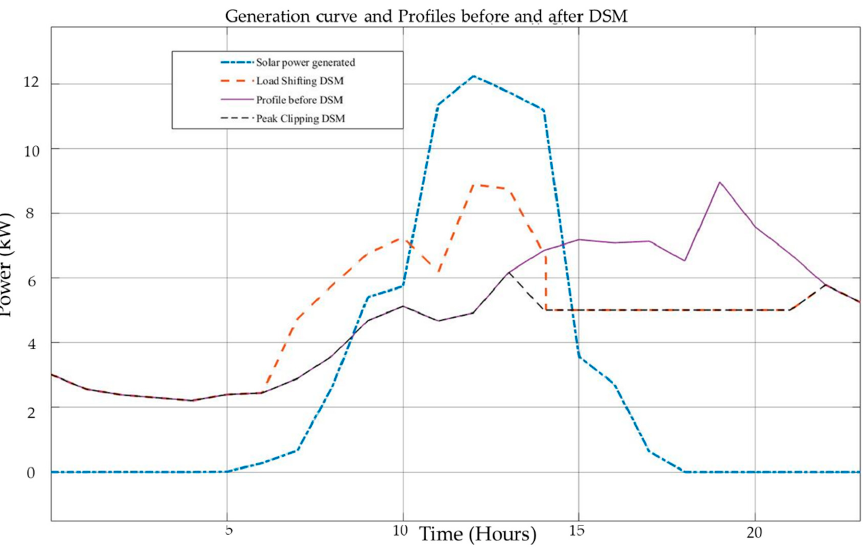
Figure 21. Comparison of solar generation and demand before and after DSM. Table 3 represents the statistical parameters of the profiles before and after DSM. The parameters displayed are the maximum (largest) and minimum (smallest) values of power consumed within the 24 h time horizon. Peak to peak power represents the differ- ence between the maximum and minimum values of power consumed before and after DSM. The mean and median values are the average and median of all the values within the original load profile and profiles after DSM. The other statistical parameters are the root mean square value of power consumed. Maximum and minimum hours represent the maximum and minimum hours (the time of day) in which the maximum and mini- mum mini-grid demand occur, respectively. The calculated peak-to-average ratio (PAR) and the percentage reduction in peak after DSM are shown. Table 3. Statistical parameters of profiles before and after DSM.